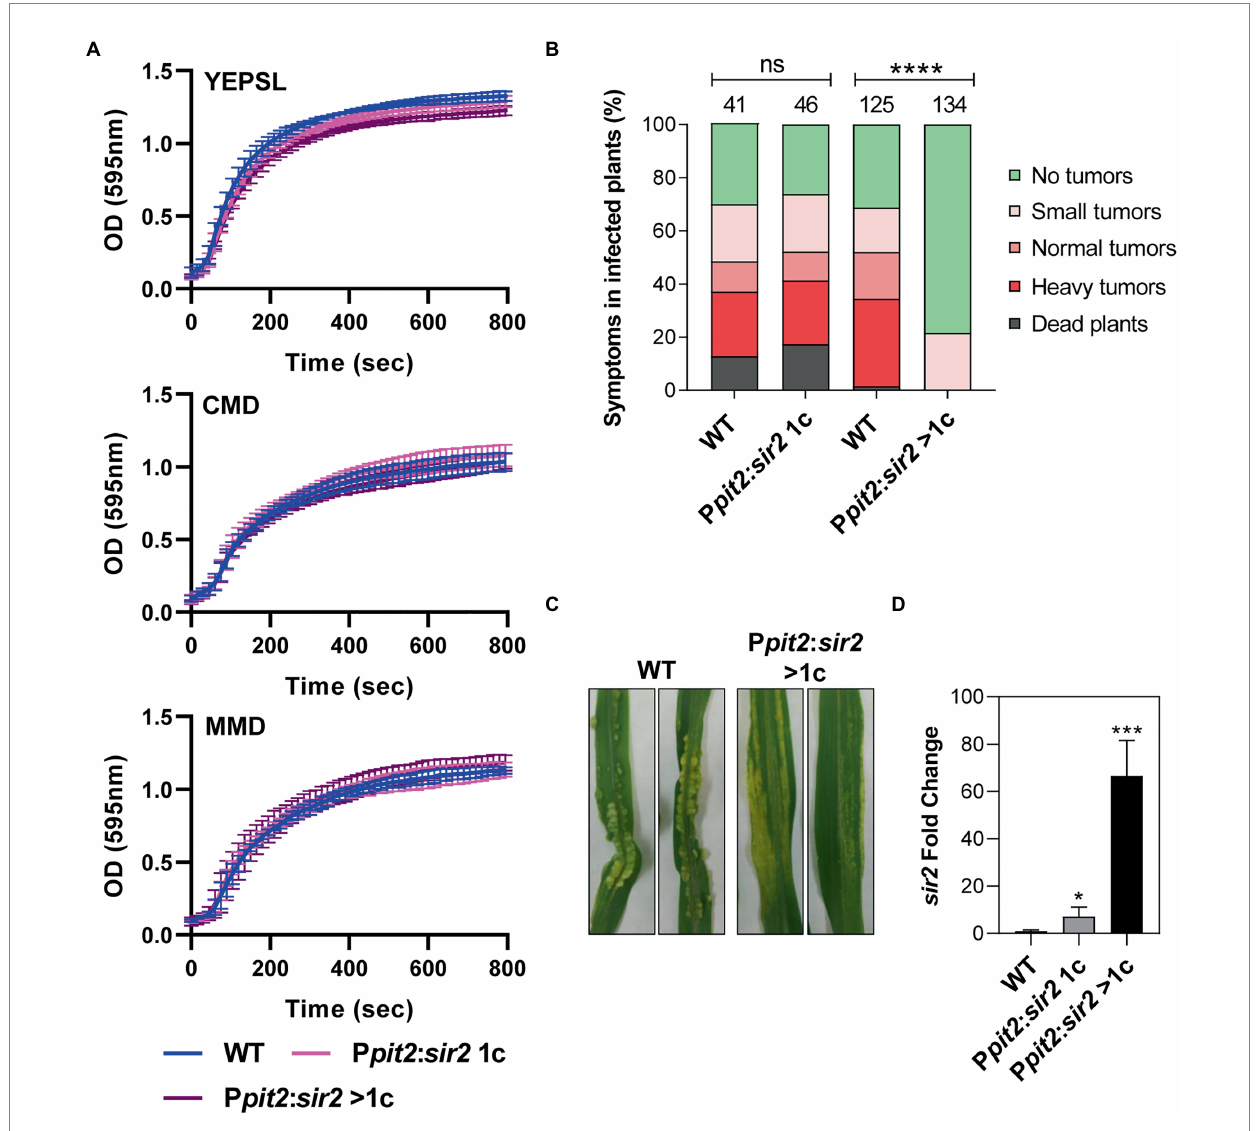
FIGURE 3 Sir2 overexpression reduces filamentation and virulence in U. maydis . (A) Growth curve of wild-type, P pit2 : sir2 1c and P pit2 : sir2 > 1c mutants growing in YEPSL, CMD or MMD media. Error bars represent the standard deviation from three independent replicates. (B) sir2 expression levels in axenic culture of wild-type and the sir2 overexpression mutants measured by RT-qPCR. U. maydis ppi1 was used as reference gene. Values were normalized to wild- type. Error bars represent the standard deviation from at least three independent replicates. Student’s t-test statistical analysis was performed (** p - value < 0.005). (C) Photograph of maize leaves infected with the indicated strains (D) sir2 expression levels of wild-type and the sir2 overexpression mutants containing one (1c) or more copies (>1c) of the P pit2 : sir2 construct infecting maize leaves at 3 dpi, measured by qPCR. U. maydis ppi1 was used as reference gene. Values were normalized to wild-type. Error bars represent the standard deviation from at least three independent replicates. Student’s t -test statistical analysis was performed (** p -value <